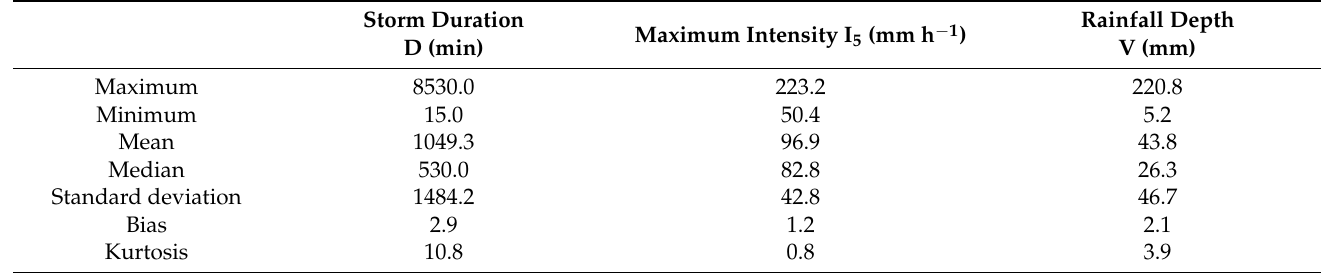
Figure 2. Representative hyetographs of some events from the sample. ( a ) Hyetograph of the 10/23/2000 event; ( b ) hyeto- graph of the 10/11/2007 event; ( c ) hyetograph of the 09/18/2018 event; ( d ) hyetograph of the 11/15/2018 event. Table 1. Univariate statistics obtained from the sample.